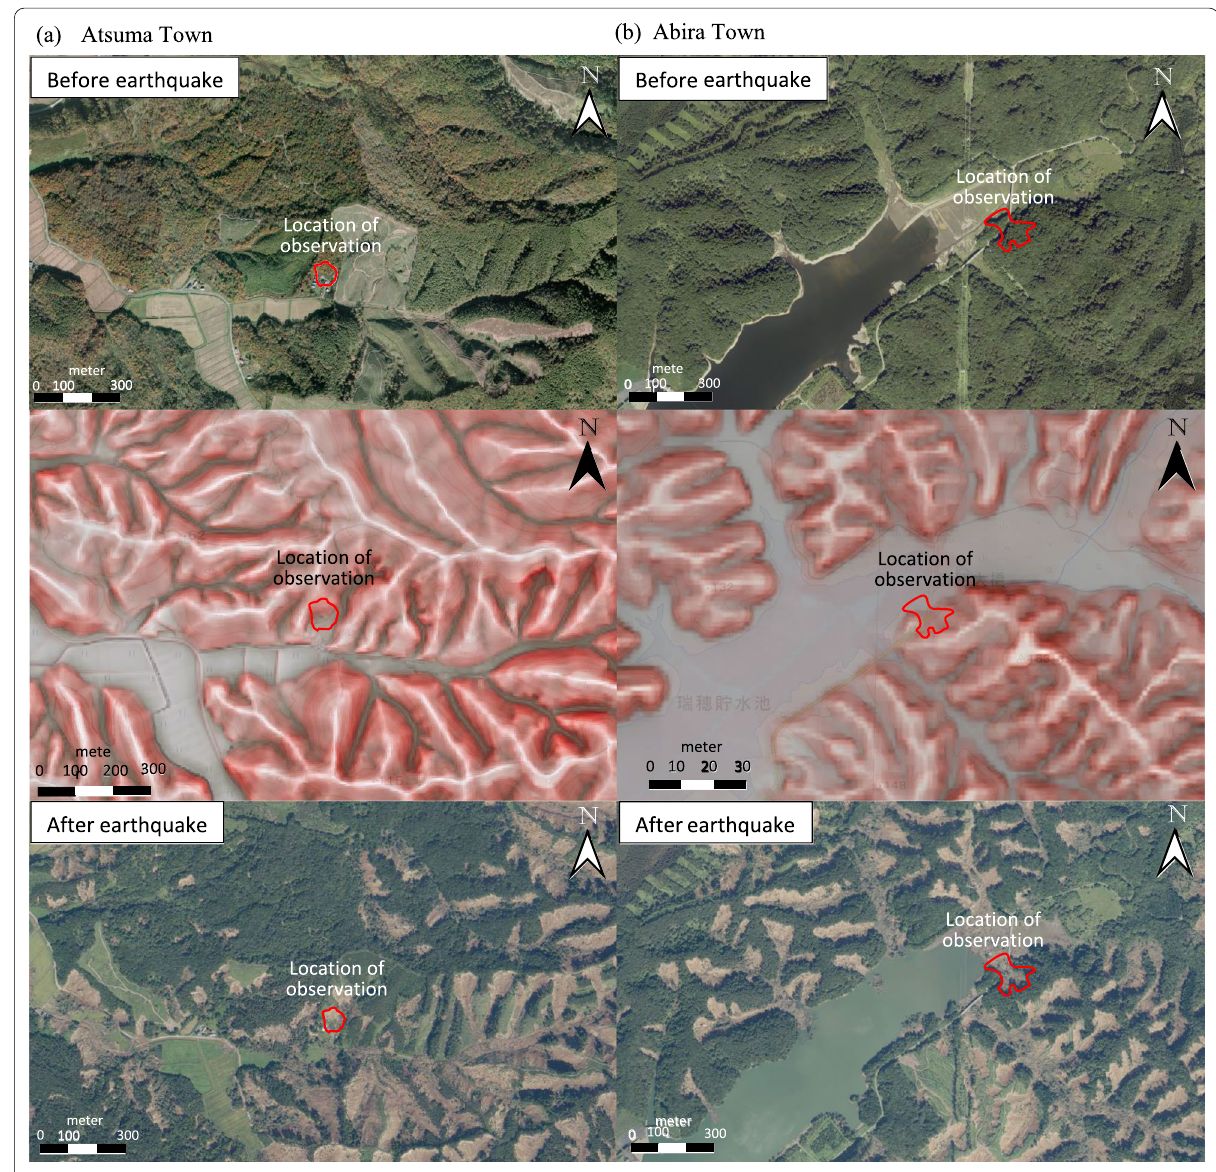
Fig. 2 Photo satellite of Atsuma Town ( a ), Abira Town ( b ) before and after earthquake, and topographic map on research areas before an earthquake (Geospatial Information Authority of Japan